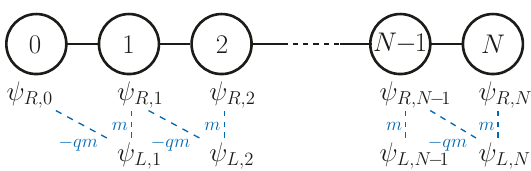
Figure 1 . A single clockwork chain with a chiral fermion, R; 0 , on the 0-th node, and vector-like fermion pairs, R;i ; L;i , on the other N nodes. The pattern of mass couplings is denoted in